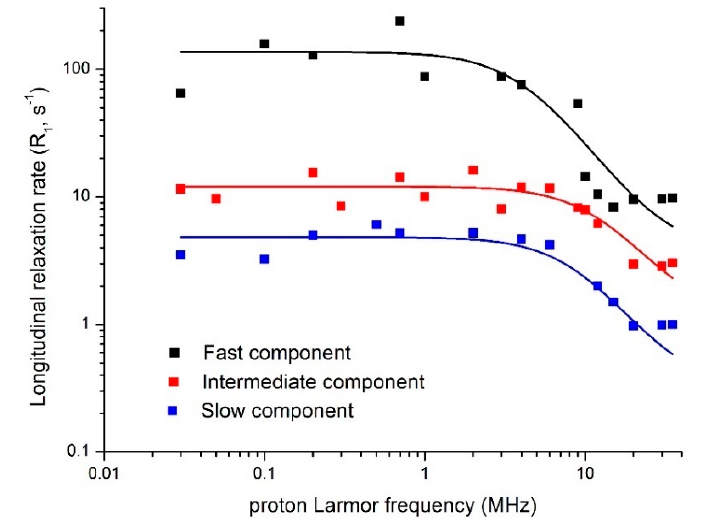
Figure 9. NMRD dispersion profiles of the three motion components of Milli–Q grade water in equilibrium with the quartz sand discussed in the text. The full lines are the fitting curves obtained by the Bloembergen–Purcell–Pound (BPP) model given in Equation (9).